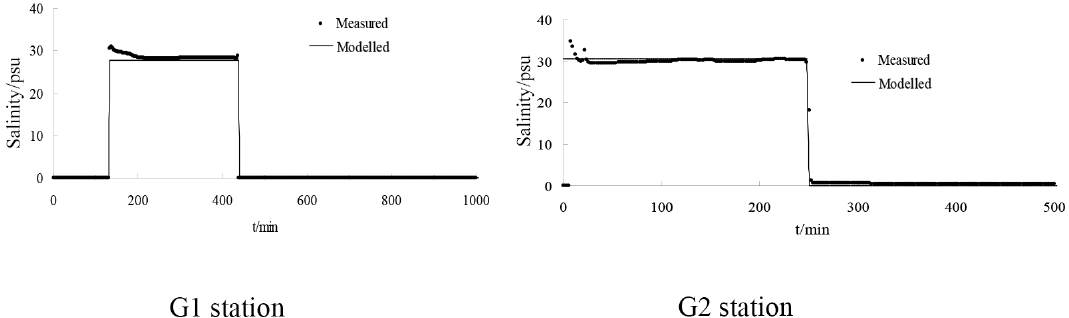
Figure 13. Comparison of the simulated and measured salinity concentrations at locations G1 and G2.